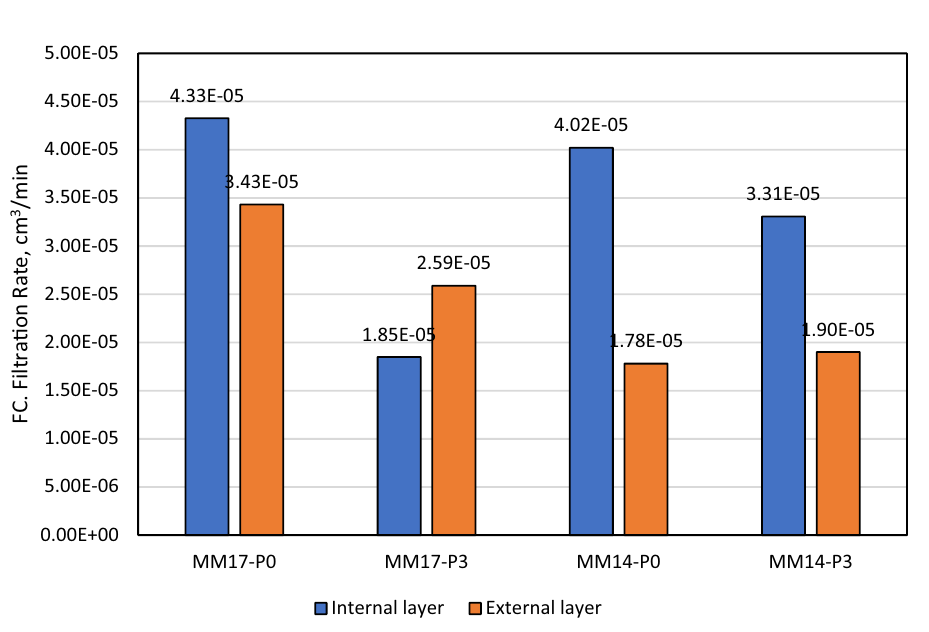
Figure 8. Filter cake rate for internal and external layers as function of perlite concentration for mud samples with perlite concentrations equal to 0 and 3